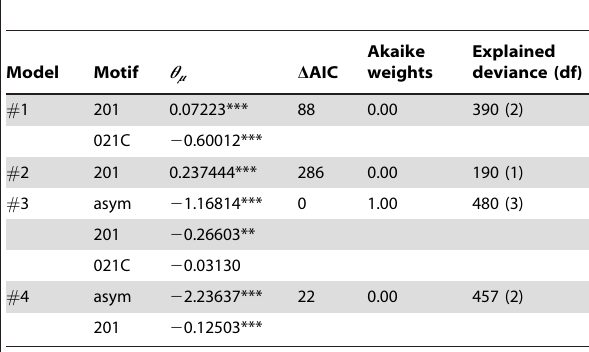
Table 2. Parameter estimates and model performance for the exponential random graph